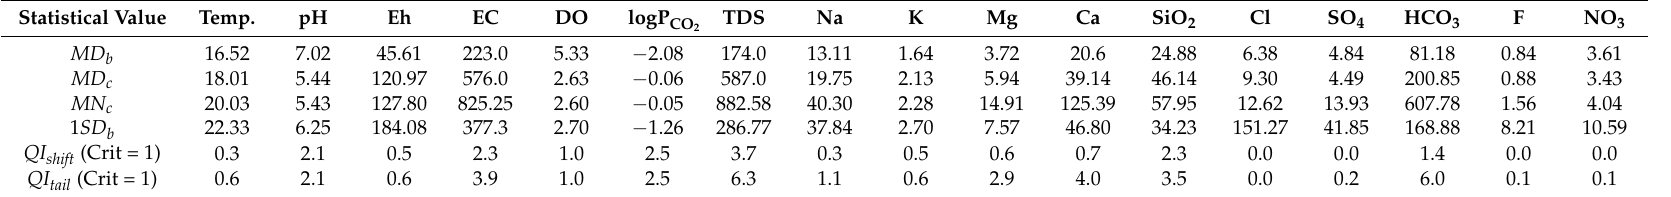
Table 11. Result of PDF verification for CO 2 -rich and ordinary groundwaters in Chungcheong Province.